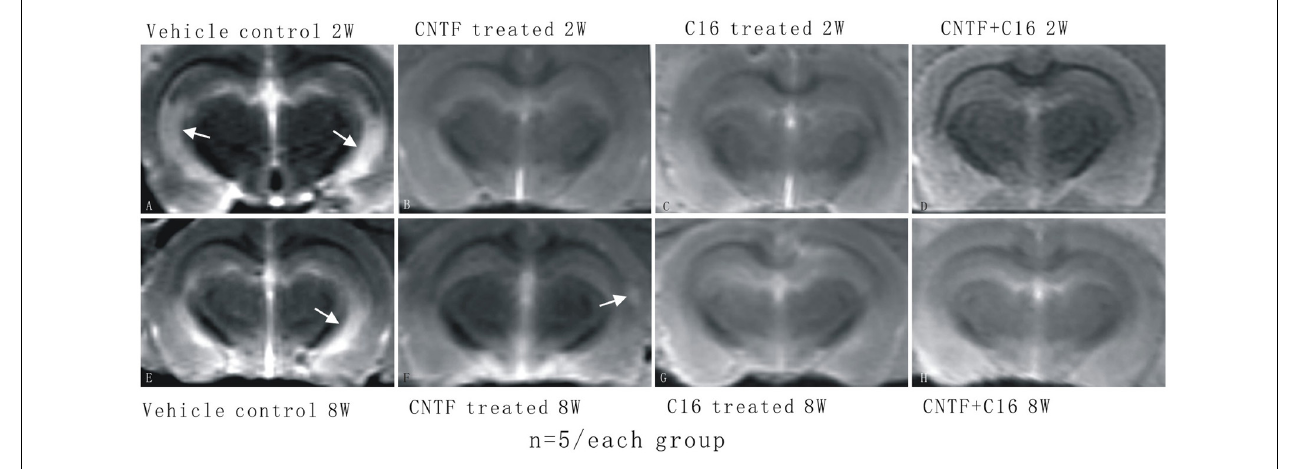
post-immunization. (E) Vehicle treated EAE rats at week 8 post-immunization. Arrow showed hyperintensity lesion area still existed, although a little smaller than lesion site at week 2 post-immunization. An intensity increased lesion area was detected in CNTF treated group [arrow in (F) ], but not in C16 treated (G) and C16 + CNTF treated (H) EAE rats at week 8